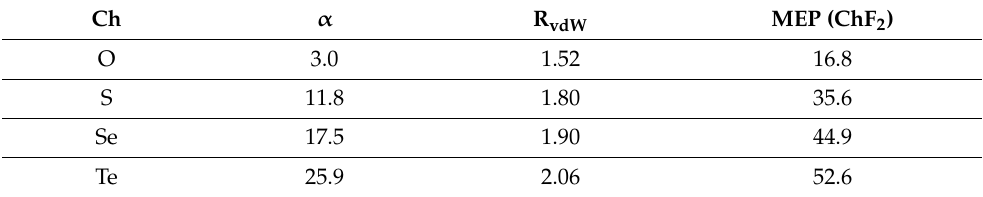
Table 5. Atomic polarizabilities ( α , a.u.) of chalcogen (Ch) elements, van der Waals radii (in Å),